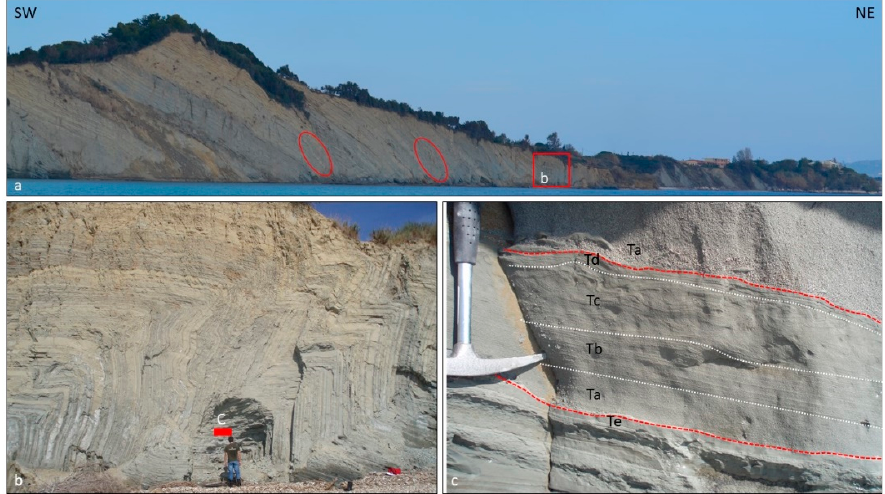
Figure 6. ( a )The section along the beach, between Keri and Ag. Sostis villages, where an Early Pliocene slump horizon ( b ) was recognized with Bouma sub-divisions ( c ). For the position, see Figure 1c.